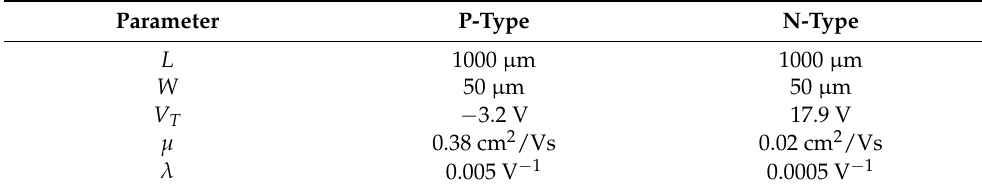
Table 1. The values of the individual parameters of p- and n-FETs used for the inverter model. Parameter P-Type N-Type L 1000 µ